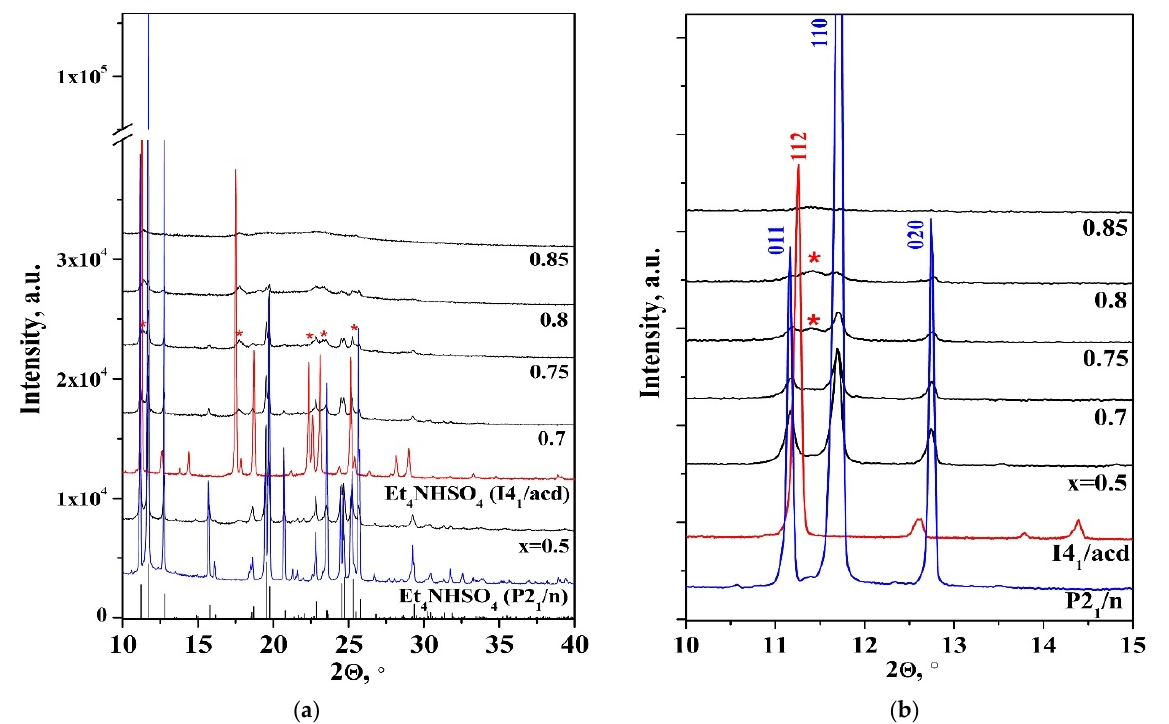
Figure 2. PXRD patterns of (1 − x)Et 4 NHSO 4 − xSiO 2 synthesized composites with different composi- tions at room temperature. Vertical markers indicate the calculated positions of Bragg reflections of Et 4 NHSO 4 ; asterisks indicate the reflections of Et 4 NHSO 4 in the I4 1 /acd phase. The PXRD patterns are presented for 2 θ ranges of 10–40 ( a ) and 10–15 ( b ) degrees.